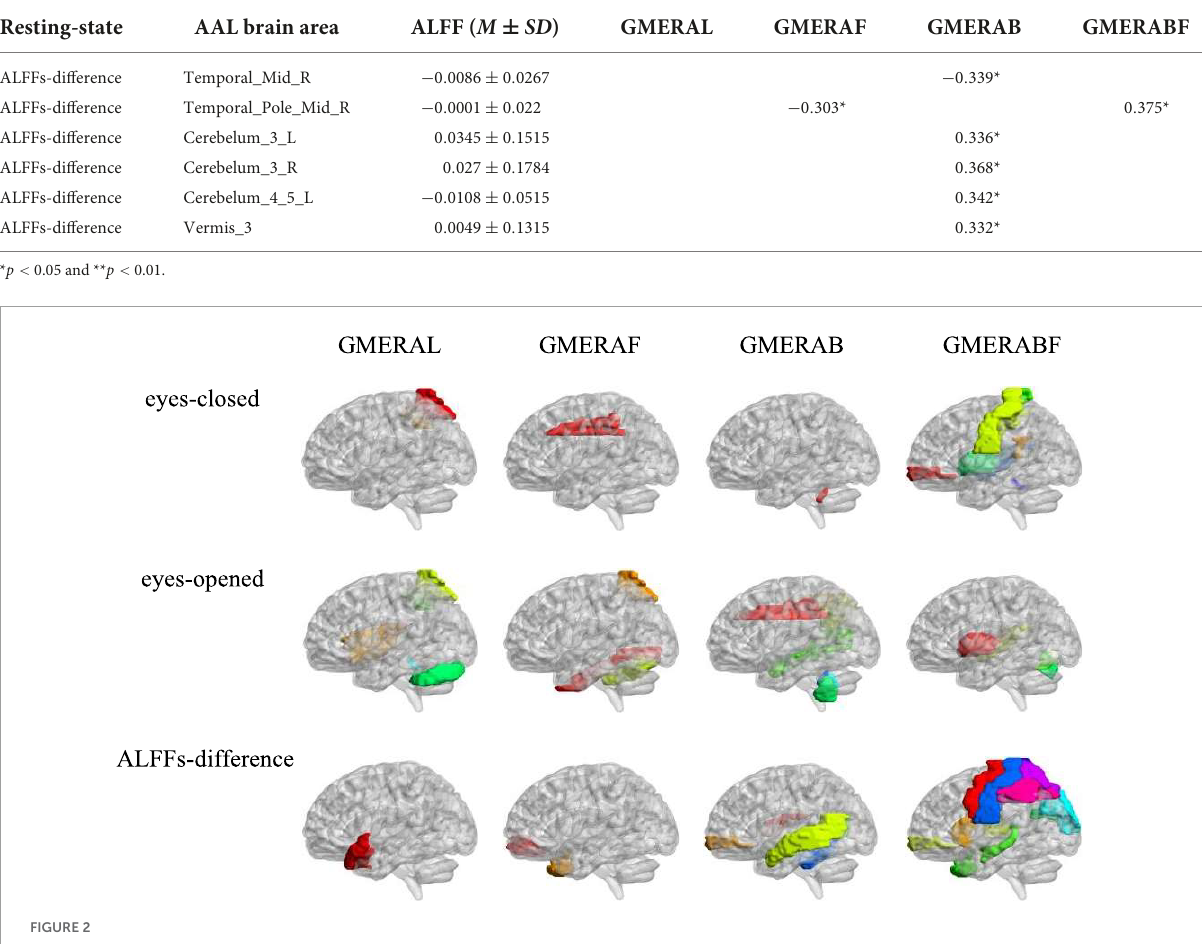
brain areas only related to the GMERAL. There were 51 brain areas only related to the Microexpression M s. (2) There were 12 common relevant brain areas between the GMERAB and the Microexpression SD s, such as some areas of the expression recognition network (Temporal_ Mid_L and Temporal_Mid_R), the microexpression